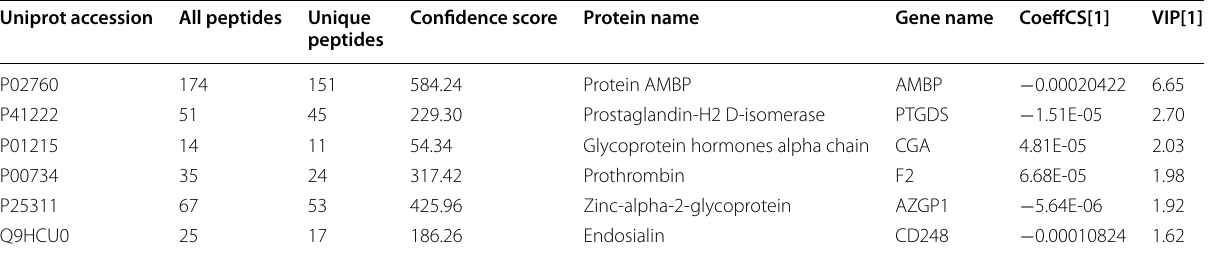
The VIP values for the comparison PE vs. HC are given in the last column. PE Preeclampsia, RC Risk controls, HC Healthy controls